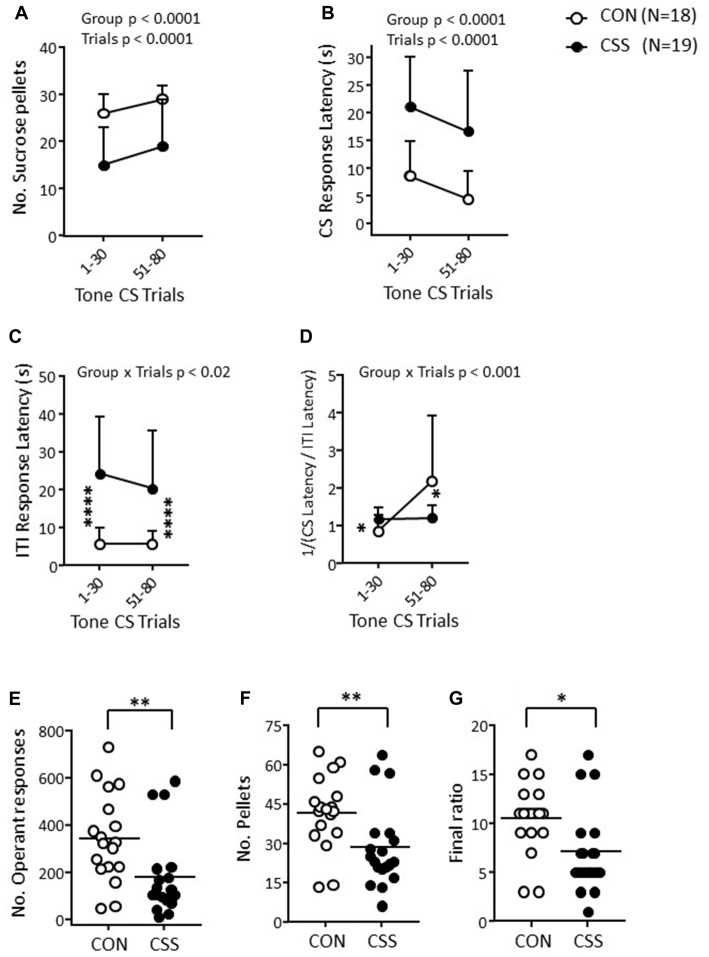
Effects of CSS on days 1–15 on reward-directed behavior in Experiment 1. (A–D) Scores for the first 30 trials per session in the RST on days 16–17: (A) Number of sucrose pellets obtained. (B) Mean response latency to a tone conditioned stimulus (CS; maximum duration 30 s) associated with pellet availability. (C) Mean response latency in the inter-trial intervals (ITI, 50 ± 30 s) between successive CS. (D) Mean CS/ITI reciprocal ratio. Values are overall mean ± SD. Significant statistical effects indicated were obtained with mixed factorial analysis of variance (ANOVA); *p < 0.05, ****p < 0.0001, in post hoc tests of single sessions following Group η Trial interaction. (E–F) Scores for the EVT on day 19, using a shallow progressive ratio schedule (PRS). (E) Number of operant responses. (F) Number of sucrose pellets earned. (G) Final ratio attained. Graphs are scatter plots and mean values per group. Significant statistical effects indicated were obtained with unpaired t-tests; *p < 0.05, **p < 0.01.